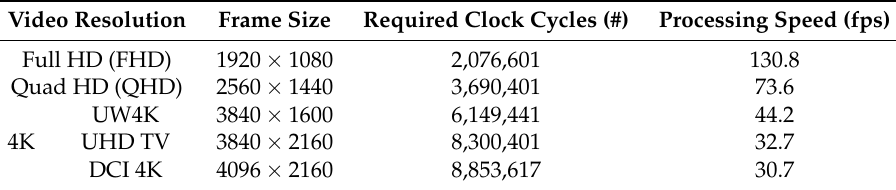
Table 11. Maximum processing speed for various video resolutions.